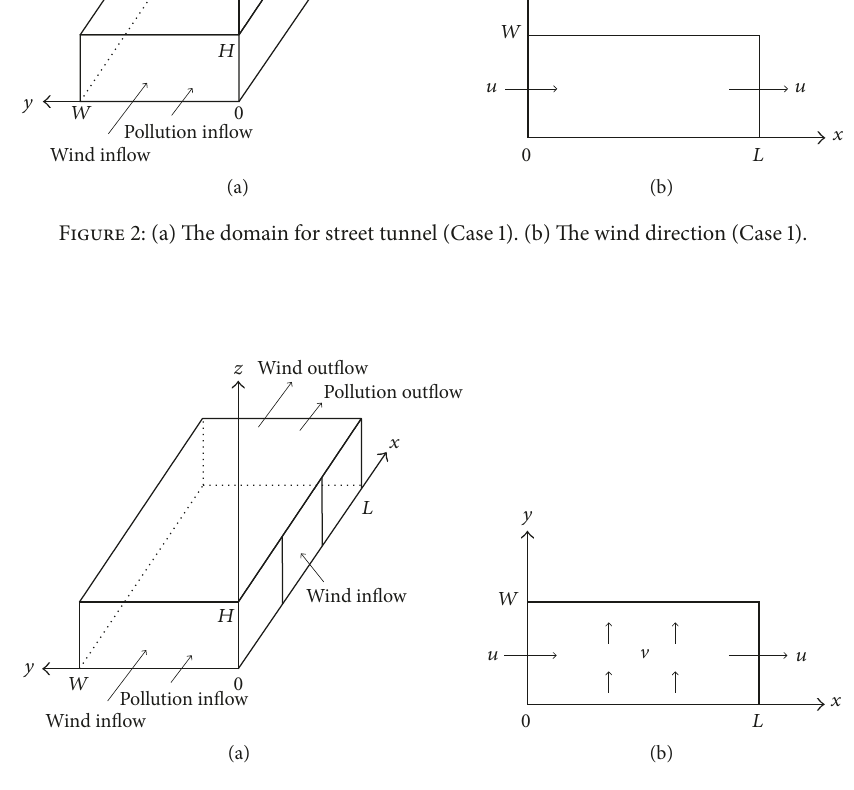
Figure 3: (a) The domain for street tunnel (Case 2). (b) The wind direction (Case 2).